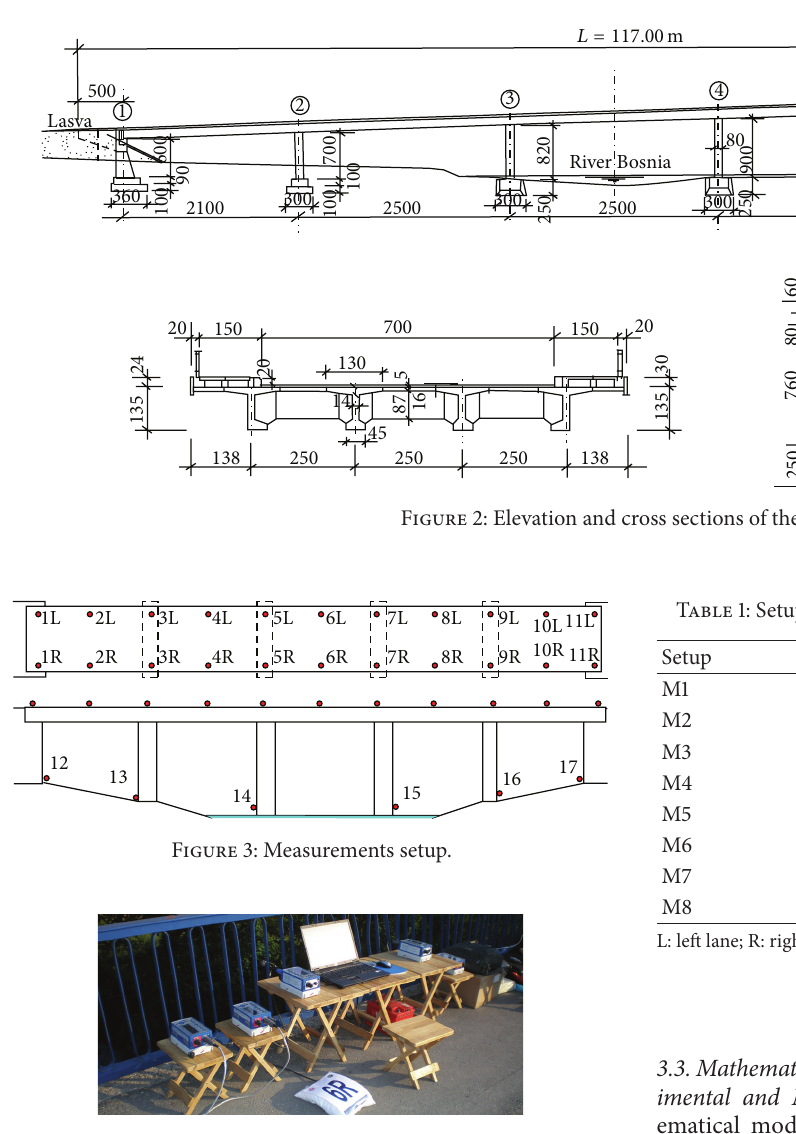
Figure 4: Test equipment.